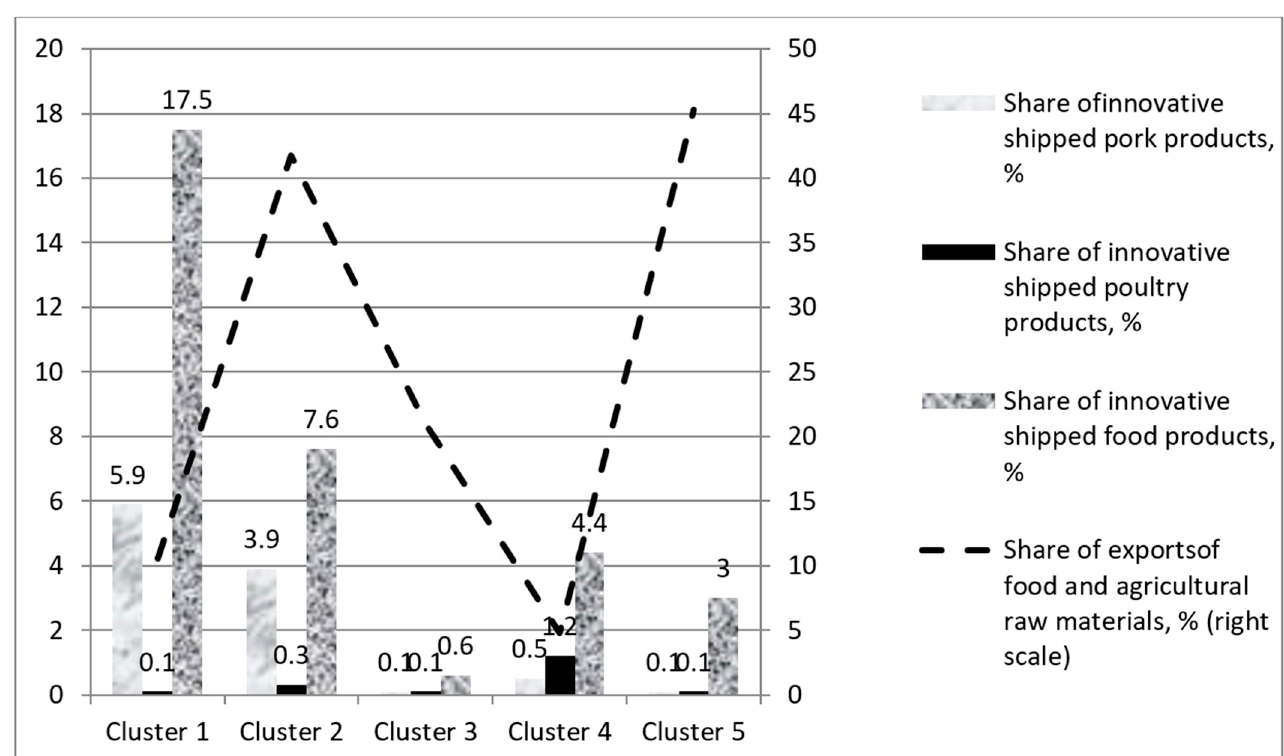
Figure 3. The relationship between food exports and innovative shipped goods across various activities.